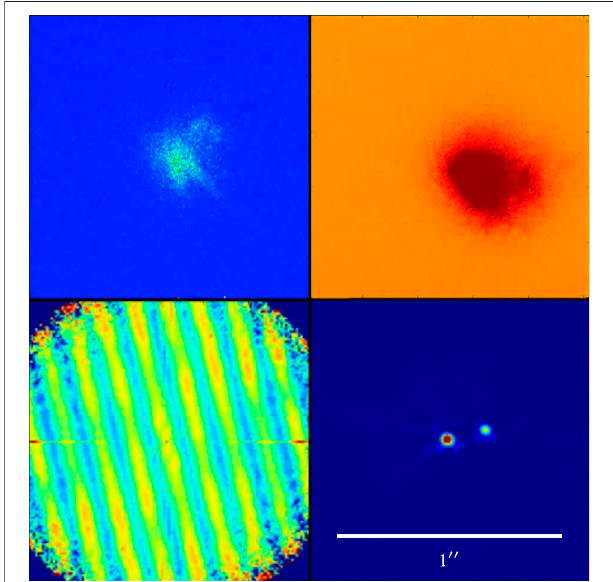
FIGURE1| Anindividual60 msexposurespeckleframe( topleft );during observations data cubes of thousands of such images are collected and individually processed. A stacked image of 1,000 speckle frames shown for comparison ( top right ). This is what a typical 1 minute exposure would look like in these conditions. The important difference between these two images is that the short integration captures interferometric combinations without blurring them out as the atmosphere shifts. In the data reduction process,eachspeckleframeiscombinedinFourierspaceproducingaFourier power spectrum ( bottom left ). From this, a reconstructed diffraction-limited image ( bottom right ) can be produced [Figure adapted from Scott